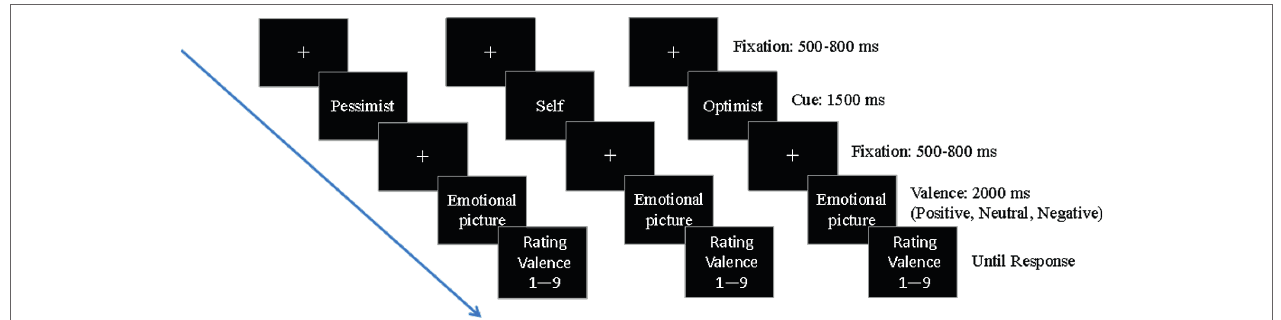
FIGURE 1 | Timeline showing the experimental design of a single trial in each block. The fixation was presented randomly for 500–800 ms, and then the cue name that reminded the participant of the nature of each judgment was shown for 1,500 ms. After 500–800 ms, the fixation was presented again, and the emotional picture was presented for 2,000 ms. Finally, participants judged the emotional picture considering the cue